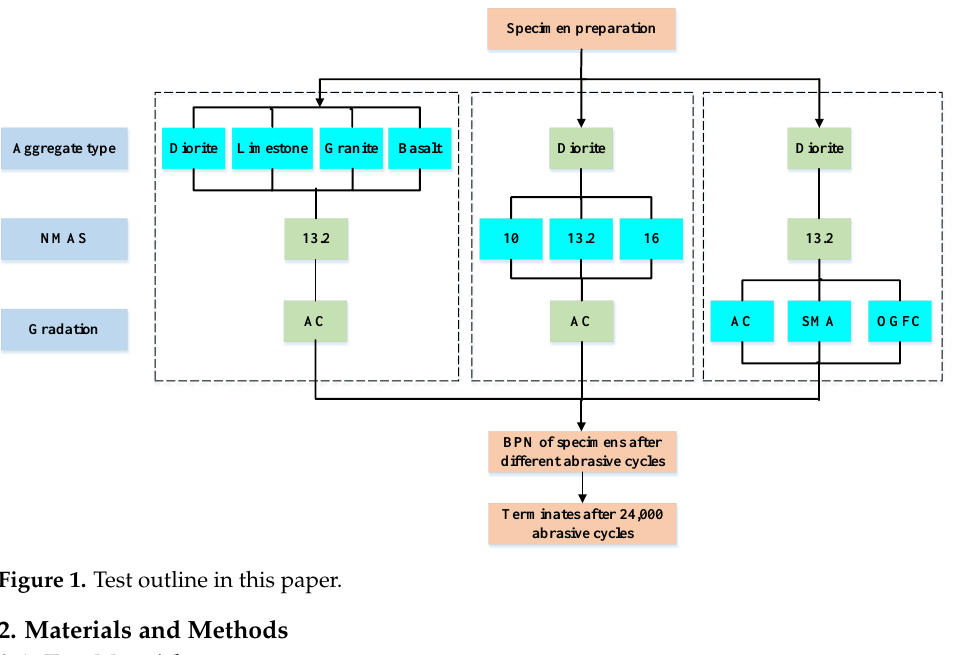
Figure 1. Test outline in this paper.